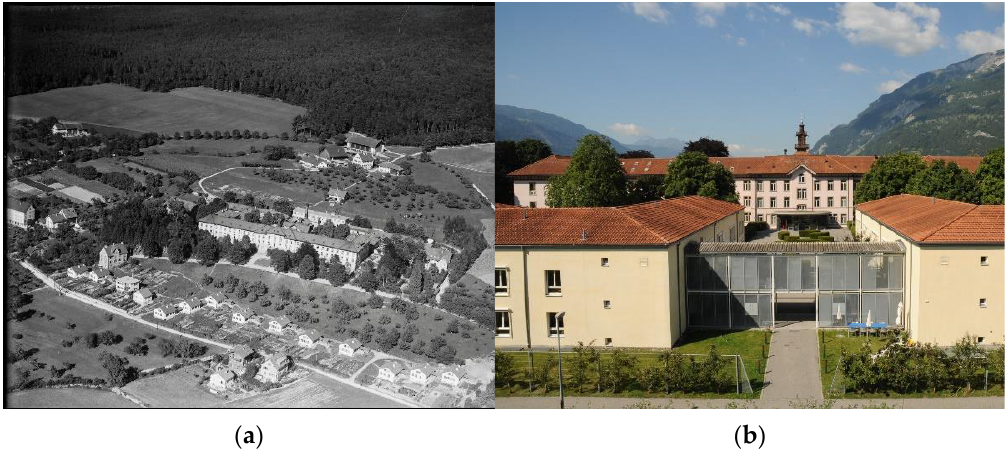
Figure 6. ( a ) Chur, Waldhaus Psychiatric Clinic, 1.9.1947, aerial photograph by Werner Friedli; source: ETH-Bibliothek Zürich, [120] CC BY-SA 4.0; ( b ) Contemporary view of Klinik Waldhaus (2011), photo by Cloot, CC BY-SA 4.0; source: [121].